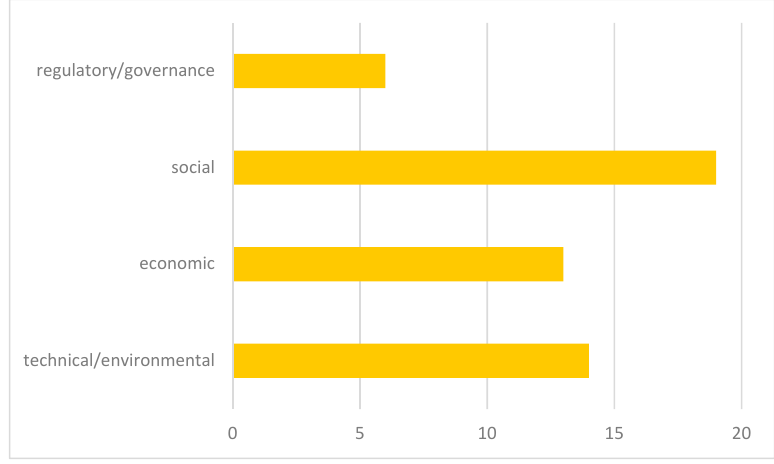
Figure 14. Progression factor distribution by discipline.